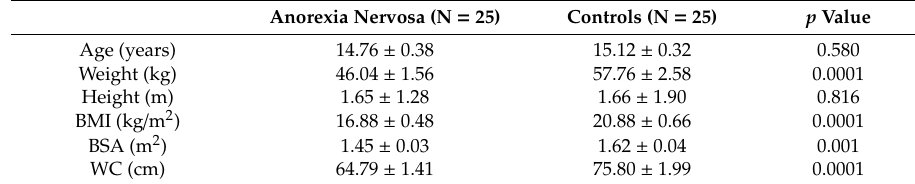
Table 1. Anthropometric characteristics of groups.